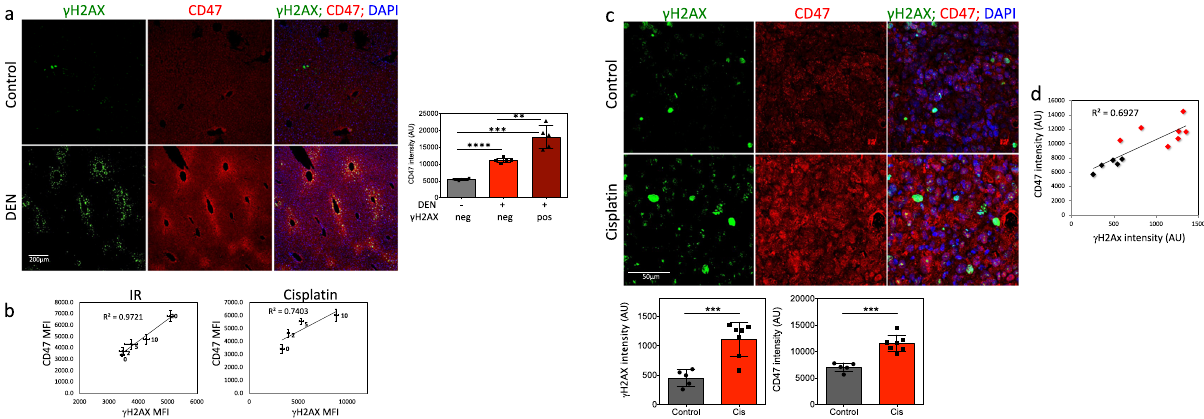
Fig. 5 CD47 overexpression in response to DNA damage in vivo. a Representative immuno fl uorescence images showing γ H2AX foci (green); CD47 (red) with DAPI counterstain (blue), in control and DEN treated livers. Graph on the right shows CD47 staining intensities in control livers (gray bar; n = 5) or DEN treated livers (red bars; n = 7). In DEN treated cells ’ CD47 expression was measured in areas negative to γ H2AX staining (light red) as compared to areas positive to γ H2AX staining (dark red). b Dose-dependent expression of CD47 in correlation with residual γ H2AX (MFI) in AB12 cells 24 h after γ -irradiation or cisplatin treatment. c Mice were injected with the mesothelioma AB12 cells and 3 days later tumors were either left untreated ( n = 5) or were treated with cisplatin (5 mg/kg; n = 7). Tumors were harvested 6 days later. Representative immuno fl uorescence images showing γ H2AX foci (green), CD47 (red) with DAPI counterstain (blue). Graphs below show γ H2AX (left panel) and CD47 staining intensities (right panel) in control (black bars) and cisplatin-treated tumors (red bars). d The level of CD47 expression correlates with the level of γ H2AX in both control (black dots) and cisplatin-